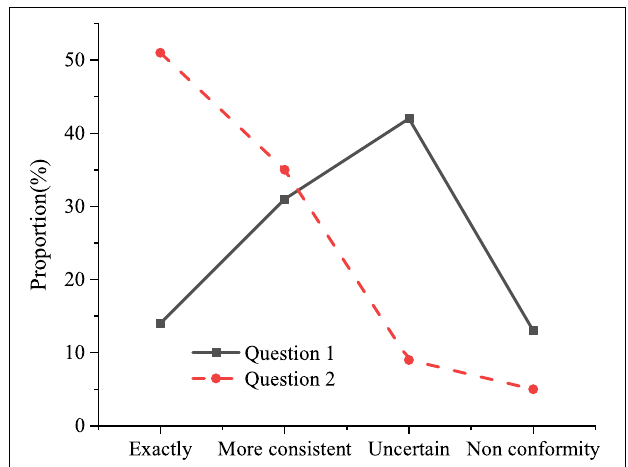
FIGURE 1 | The statistical results of the questionnaire on educational